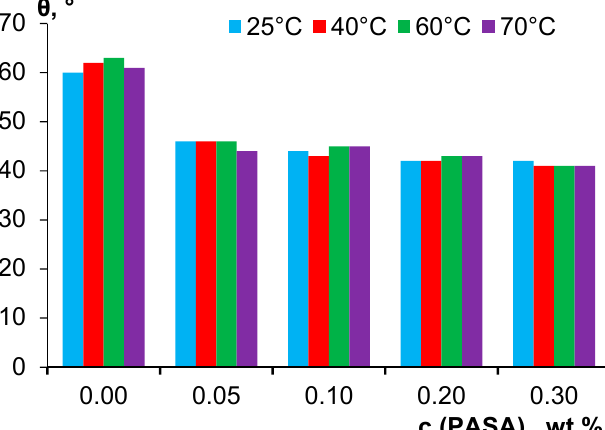
Figure 9. Water contact angle ( θ ) vs. PASA concentration in the coagulation bath at different coagulation bath temperatures.